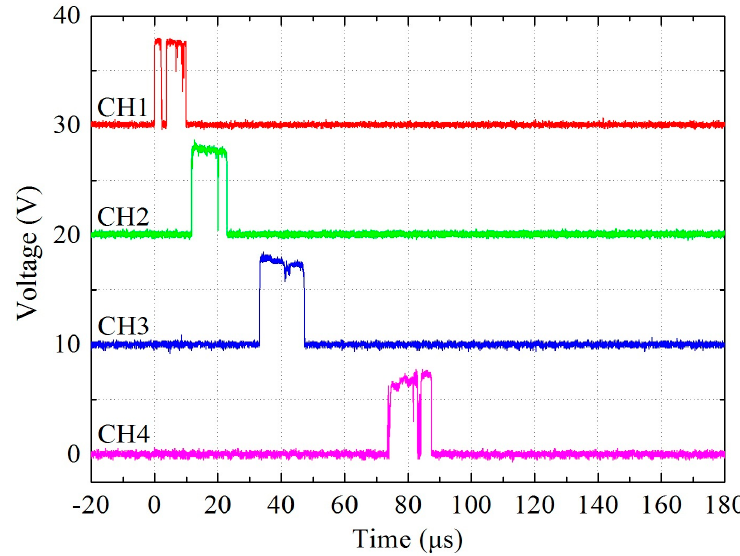
Figure 6. Typical shock front signals (Test No. 5).